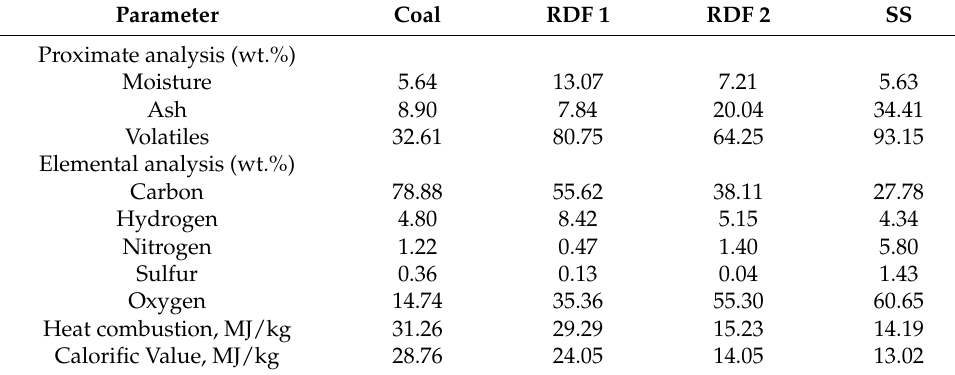
Elemental analysis (wt.%)